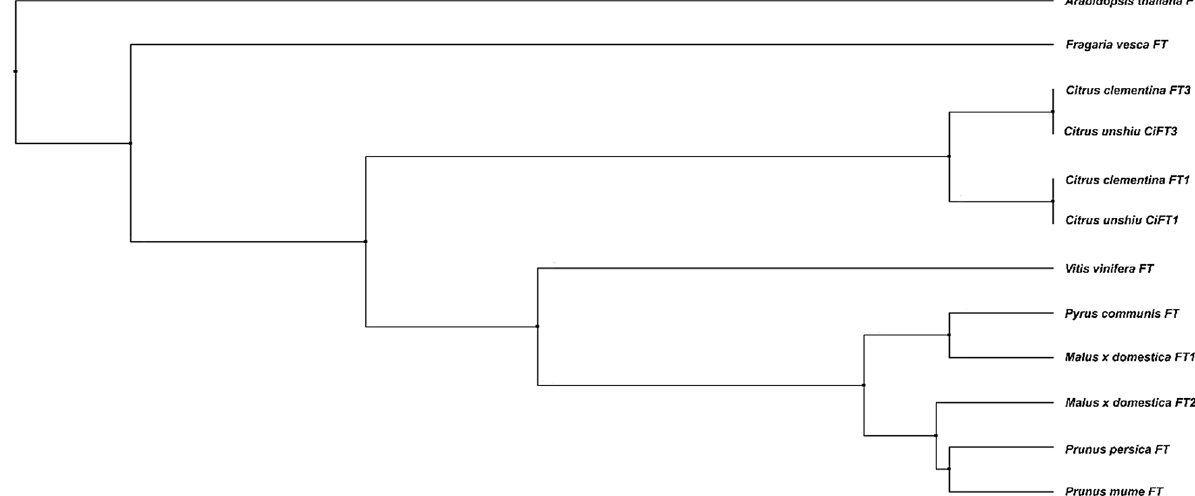
Figure 2. Phylogenetic analysis of FT protein sequences of multiple plant species. Sequences evaluated include: Arabidopsis thaliana FT (AAF03936), Citrus clementina FT1 (MT707614), Citrus clementina FT3 (MT602515),